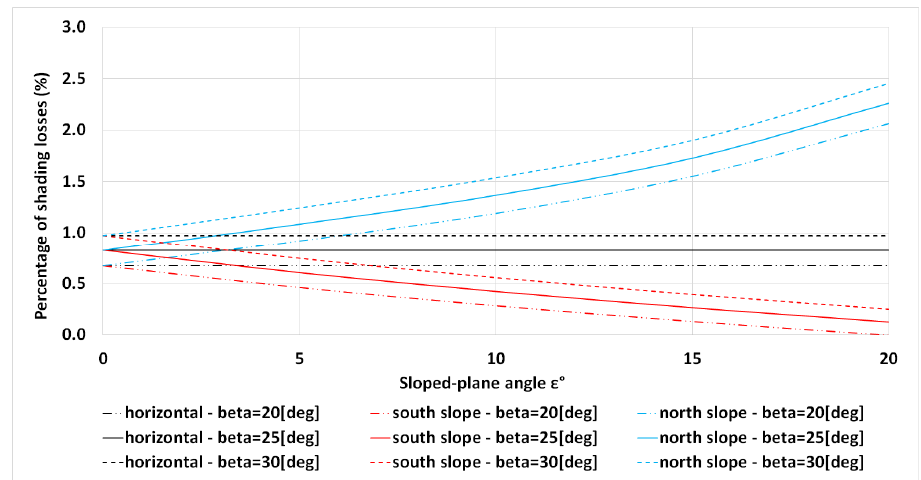
Figure 10. Percentage of shading losses between the first and second collector row; 0 H = 2.12 m,L = 40 m, φ = 32 ◦ N, β = 20 ◦ , 25 ◦ , 30 ◦